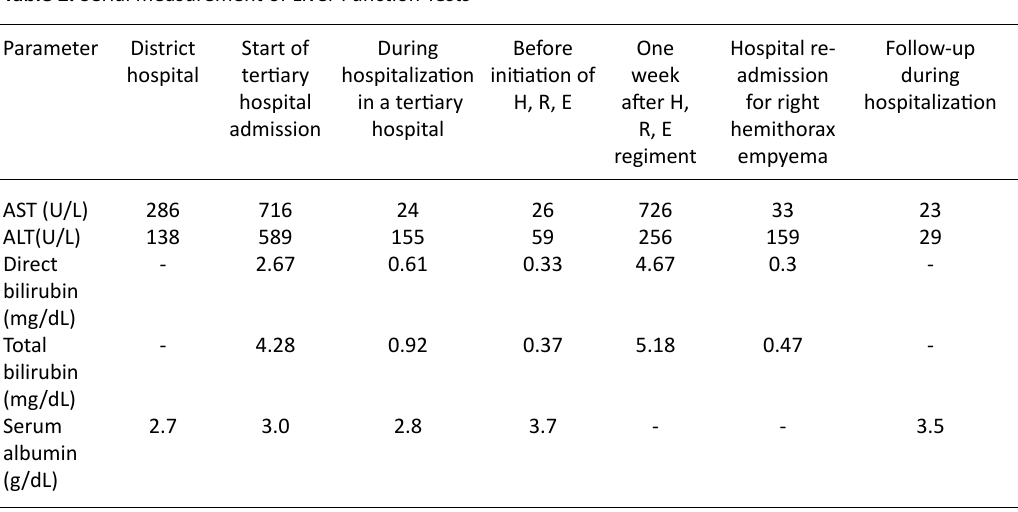
table 2. Serial measurement of Liver Function Tests Parameter District Start of During Before One Hospital re- Follow-up hospital tertiary hospitalization initiation of week admission during hospital in a tertiary H, R, E after H, for right hospitalization admission hospital R, E